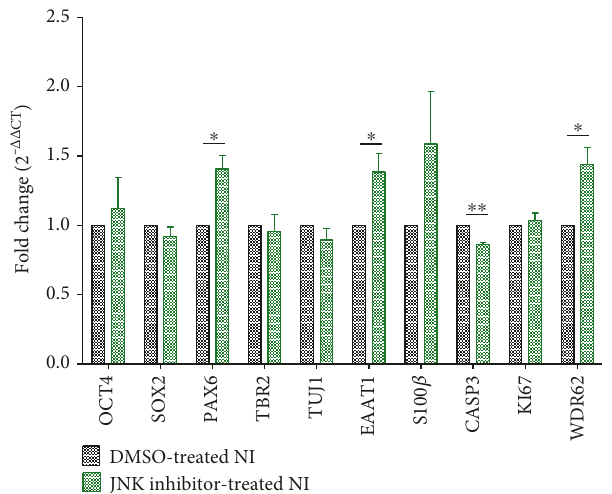
Figure 5: JNK inhibition e ff ect on the expression of WDR62 and hPSC speci fi cation to neural and glial progenitors. Q-PCR data shows signi fi cant expression increase of PAX6 ( P = 0 01 ), EAAT1 ( P = 0 04 ), and WDR62 ( P = 0 02 ) and decreased expression of CASP3 ( P = 1 0 E − 03 ) in hPSC-derived neural progenitors treated with JNK inhibitor versus no treatment at day 14 neural induction ( n = 3 independent experiments). Two-tailed t -test was used to assess signi fi cance. ∗ P < 0 05 ; ∗∗ P < 5 0 E − 03